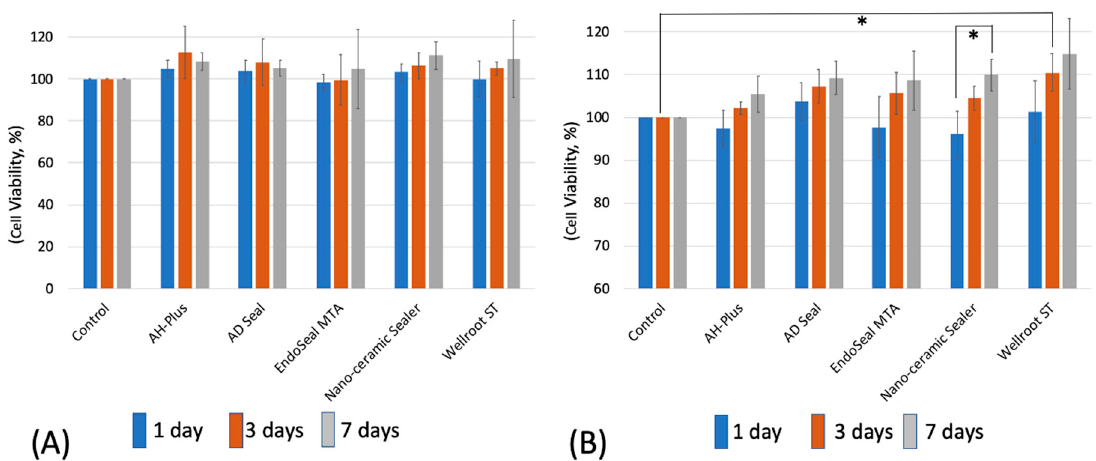
Figure 3 . Cell viability of hPDLSCs by MTT assay using extraction media derived from the set sealers at ( A ) 48 h and ( B ) 72 h for 7 days (* means significant difference between groups connected by bar. p < 0.05).